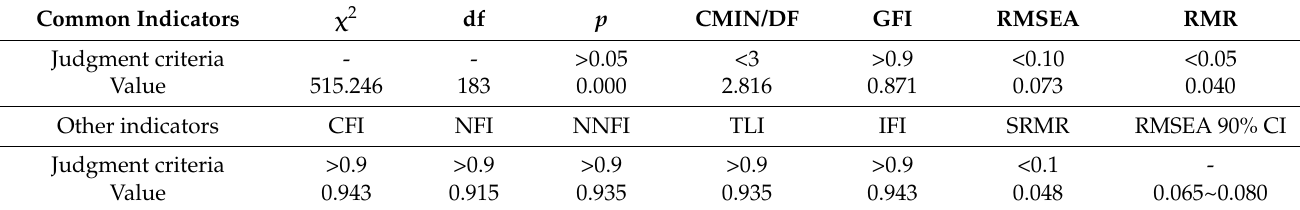
Table 5. The goodness of fit indices for tested models.